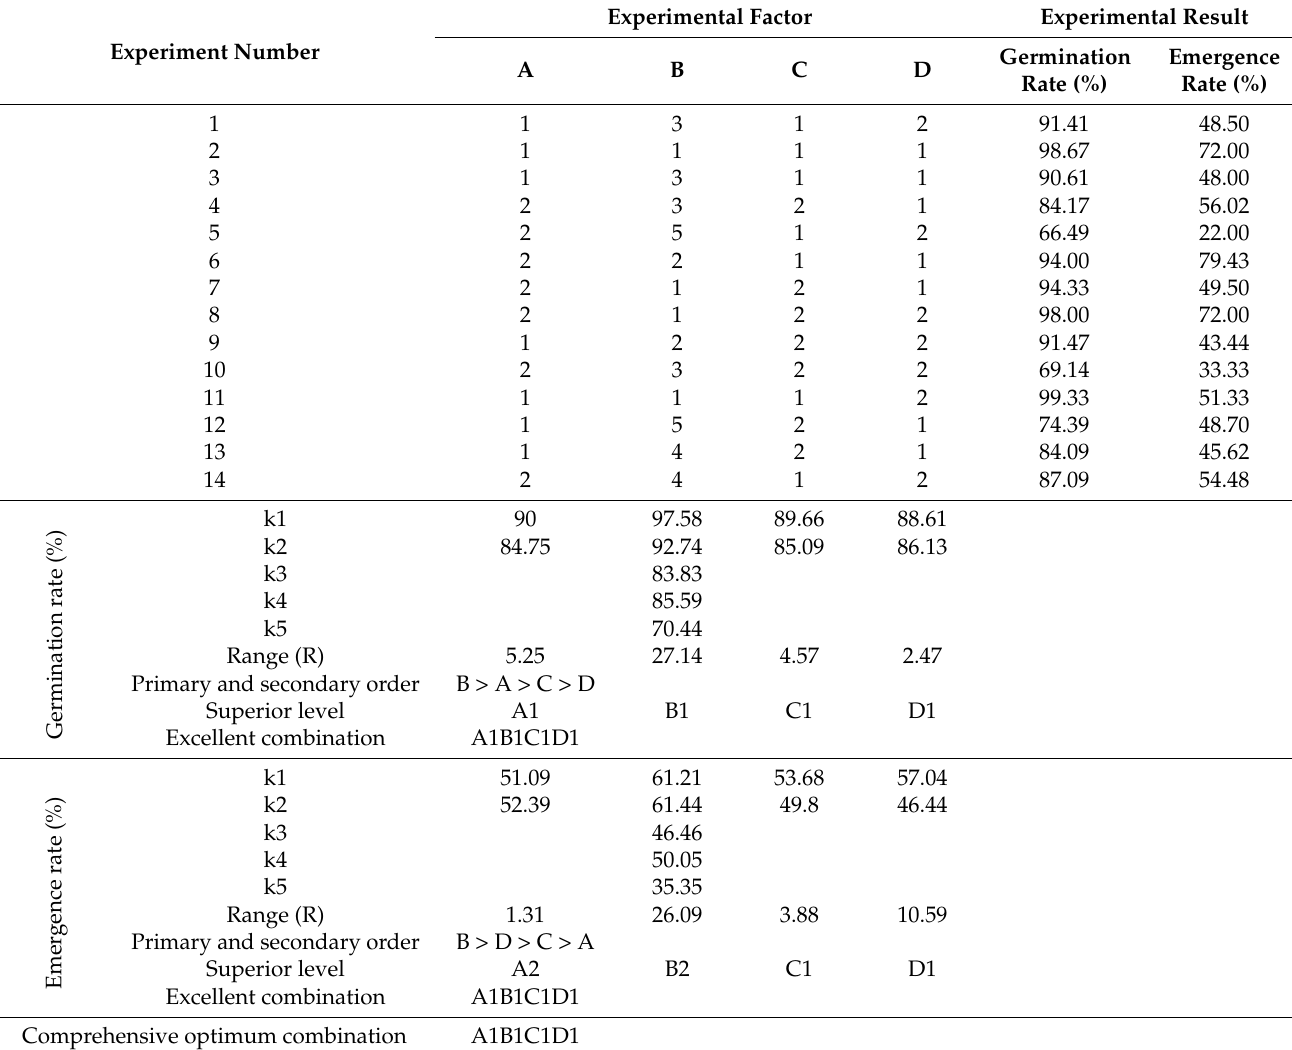
Table 5. Orthogonal experimental design and optimum results of Marselan grape